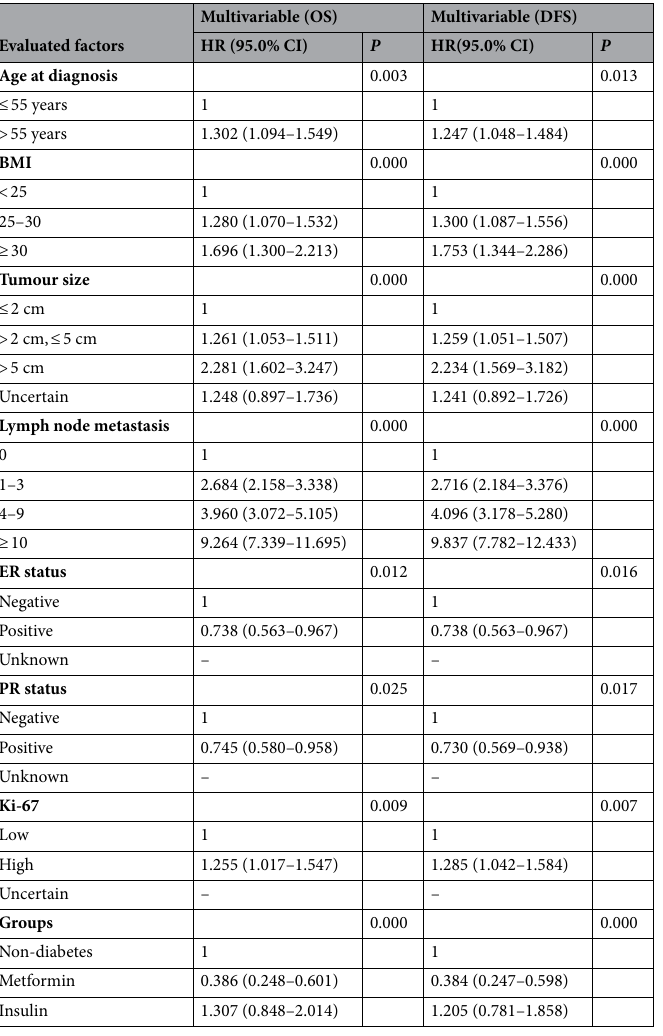
Table 2. Multivariable Cox analyses of clinical features on OS and DFS in patients with T2DM.